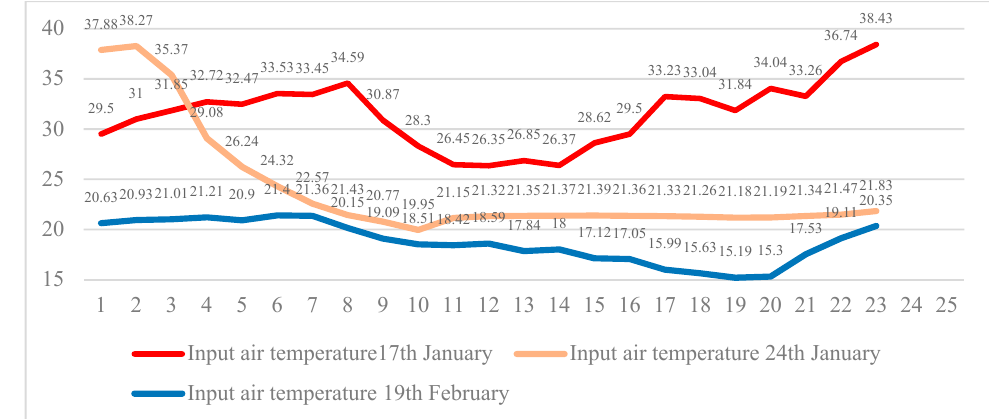
Figure 6. Input air temperature comparison in three summer ideal day.